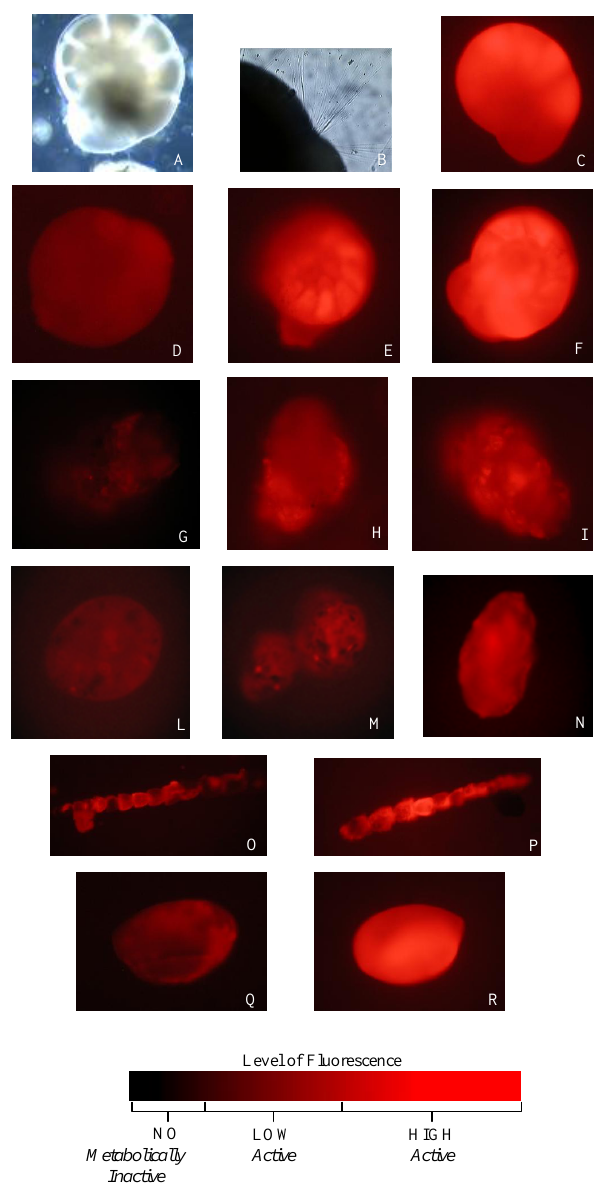
Fig. 3. Fluorescence emission after FISH hybridization. (A) Ammonia sp., 300µm, at optical microscope; (B) Ammonia sp. at optical 3